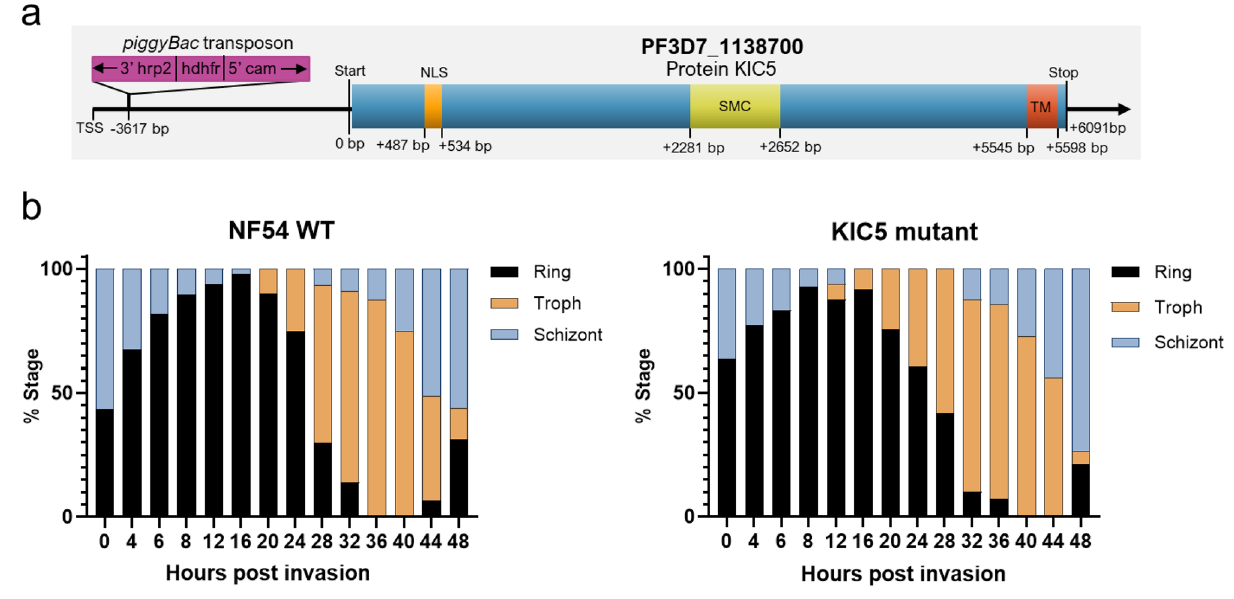
Figure 1. Characteristics of the KIC5 mutant. ( a ) The piggyBac transposon insertion in the KIC5 mutant lies within the 5 ′ UTR of the KIC5 gene, specifically 10 bp+ of the annotated TSS. ( b ) Analysis of the percentages of ring, trophozoite, and schizont during the 48-h intraerythrocytic cycle progression in wild-type NF54 (left) and KIC5 mutant (right). Results were obtained via microscopic analysis of synchronized cultures with two bio- replicates. Fisher’s Exact Test was performed, determining no significant differences between the amount of ring, trophozoite, and schizont microscopy cell counts per timepoint for the KIC5 mutant vs NF54 (Supplementary Table S1). Graphs created in GraphPad Prism 9 and statistics performed in R. NLS nuclear localization signal, SMC structural maintenance of chromosome domain, TM transmembrane